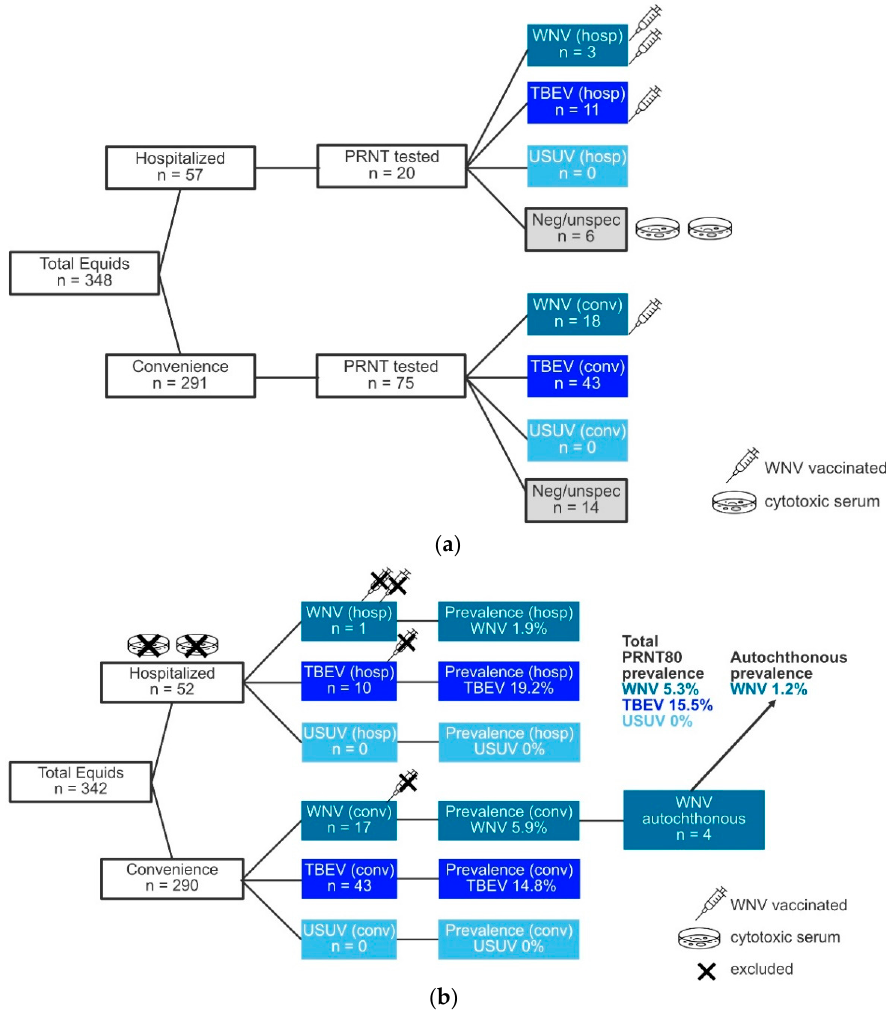
Figure 2. Laboratory results of PRNT-80: ( a ) IgG ELISA reactive or indeterminate samples tested with PRNT-80. Equids with cytotoxic serum, depicted by the symbol of a Petri dish, and WNV-vaccinated equids, depicted by the symbol of a syringe, are included. The number of symbols represents the number of equids; ( b ) Results of PRNT-80-positive samples are highlighted, negative samples are omitted. In two hospitalized horses, cytotoxic serum prohibited reliable neutralizing antibody analysis and they were therefore excluded, decreasing PRNT-80 group hosp to n = 55 and total equids (hosp + conv) to n = 346. Further subtracting WNV-vaccinated equids decreased equid numbers in hosp to n = 52, in conv to n = 290, and in total equids to n = 342. Abbreviations: PRNT = 80% plaque reduction neutralization test, WNV = West Nile virus, TBEV = Tick-borne encephalitis virus, USUV = Usutu virus, hosp = hospitalized equids, conv = convenience field sampled